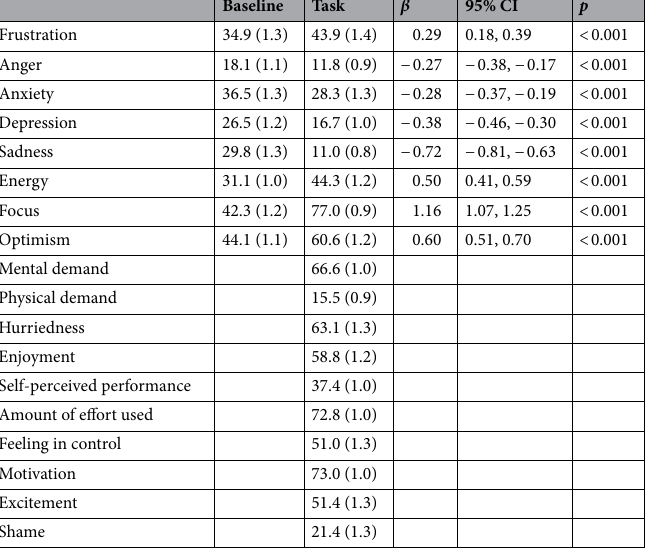
focus, and optimism all increased (on average + 21 points) from baseline to during the task. Supplementary Materials Fig. S2 (sickness) and S3 (sleep health) show the statistics and mean ratings of negative and positive mood at baseline and during the Frustration Tolerance Task, separated by sickness and sleep health groups. Replicating the study in an independent sample of 113 participants produced almost identical task responses (see Supplementary Materials Fig. S1b), indicating that the 10-point Likert scale can be validly rescaled to the 0–100 VAS and reliability of the results. All results of the replication study are shown in the Supplementary Materials 5.3. Sickness and sleep measures. The exploratory factor analysis extracted two factors, see Supplemen- tary Material Table S1 for the factor loadings. Based on the symptoms that loaded onto each factor, Factor 1 (e.g., depressed, drained, do not wish to do anything) is referred to as ‘depression-like sickness’ and Factor 2 (e.g., cough, fever, muscle aches) as ‘infection-like sickness’. Figure 1 shows the Pearson correlation coefficients between all sickness and sleep health variables. Baseline frustration. Depression‑like sickness, infection‑like sickness, self‑rated health. All three sickness- related factors predicted frustration at baseline: depression-like sickness ( β = 0.66, 95% CI [0.59, 0.72], p < 0.001), infection-like sickness ( β = 0.49, 95% CI [0.41, 0.56], p < 0.001), and self-rated health ( β = − 0.44, 95% CI [− 0.51, − 0.36], p < 0.001). As shown in Fig. 2 and Supplementary Materials Table S2 (original values before rescaling), those high in depression-like sickness and infection-like sickness, and those with low self-rated health reported higher frustration at baseline, followed by those moderate in these stressors. Low frustration was observed in those with low depression-like sickness, low infection-like sickness, and in those with high self-rated health (depression-like sickness: F (2, 517) = 148.59, p < 0.001; infection-like sickness: F (2, 517) = 69.41, p < 0.001; self- rated health: F (2, 517) = 45.36, p < 0.001). Sleepiness, sleep quality, and sleep duration. Greater sleepiness ( β = 0.28, 95% CI [0.20, 0.36], p < 0.001) and lower sleep quality ( β = − 0.24, 95% [CI − 0.33, − 0.16], p < 0.001) were associated with higher frustration at base- line. As shown in Fig. 2 and Supplementary Materials Table S2 (original values before rescaling), frustration levels were highest in those with high sleepiness and in those with the worst sleep quality, followed by those with moderate sleepiness and sleep quality, and low frustration ratings were observed in those with low sleepiness and good sleep quality (sleepiness: F (2, 517) = 19.96, p < 0.001; sleep quality: F (2, 517) = 11.96, p < 0.001). Sleep dura- tion did not significantly predict baseline frustration ( β = 0.02, 95% CI [− 0.07, 0.10], p = 0.707) and frustration at baseline was not significantly different between short, normal, and long sleepers ( F (2, 517) = 0.18, p = 0.836). There was neither a linear ( F = 0.14, p = 0.707) nor quadratic ( F = 1.34, p = 0.262) relationship evident between sleep duration and frustration. Task-induced frustration. Sickness and task‑induced frustration. A task (baseline, task) × depression- like sickness interaction ( β = − 0.33, 95% CI [− 0.43, − 0.23], p < 0.001) was evident for frustration. Similar ef- fects were found for infection-like sickness ( β = − 0.34, 95% CI [− 0.44, − 0.24], p < 0.001) and self-rated health